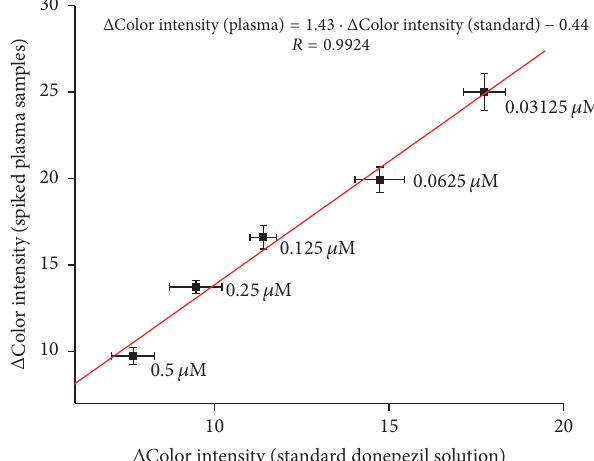
Figure 11: Verifying of donepezil assay in plasma samples compared to standard donepezil solution. Error bars represent standard error of the mean for 𝑛 =